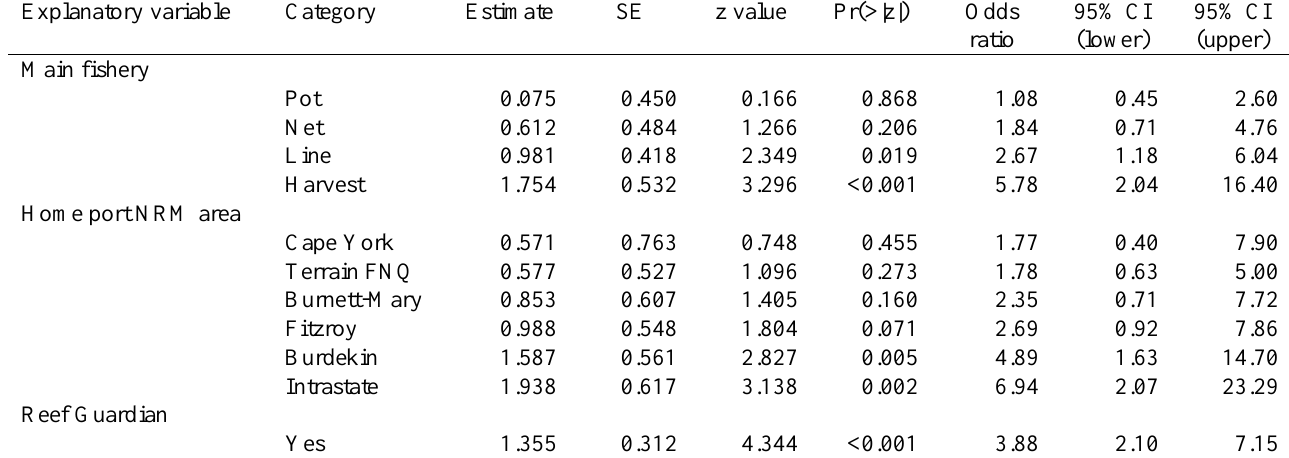
Table A1.3. Cumulative link model estimates of fishers’ (n=191) trust in information from GBRMPA and retained explanatory variables reflecting respondent characteristics. Log likelihood: -348.44, condition number of Hessian: 1.6e+03, AIC: